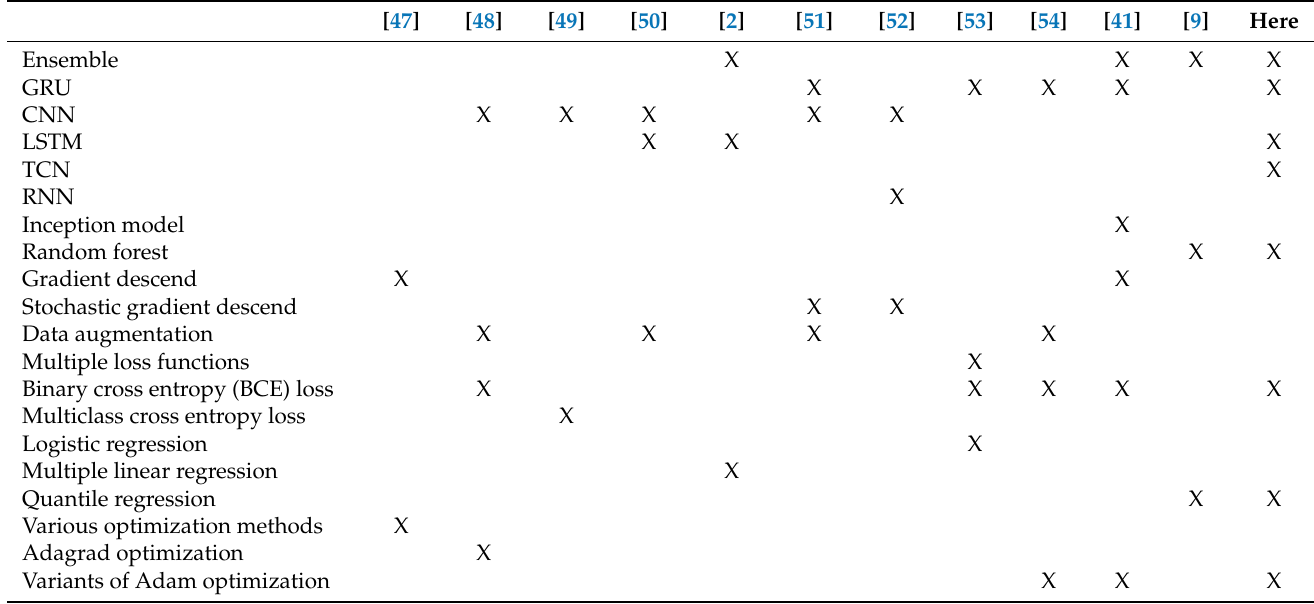
Table 1. Summary of existing deep learning studies. An X indicates whether a particular technique or model was